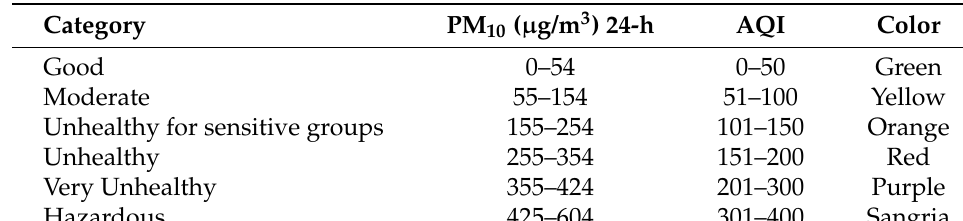
Table 2. Breakpoints for the Air Quality Index—AQI [36].